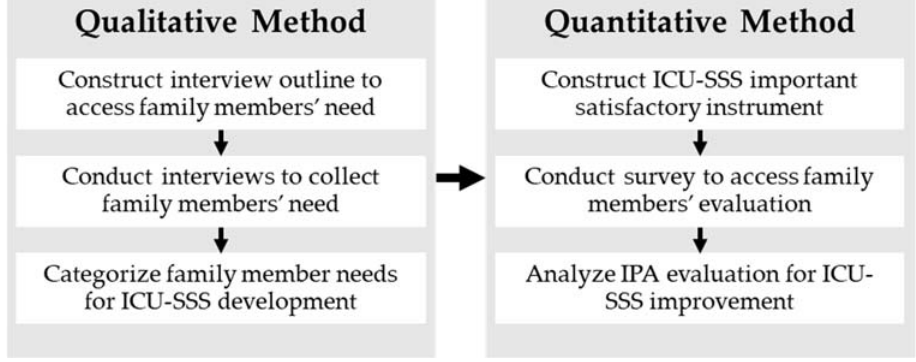
Figure 1. The research process.